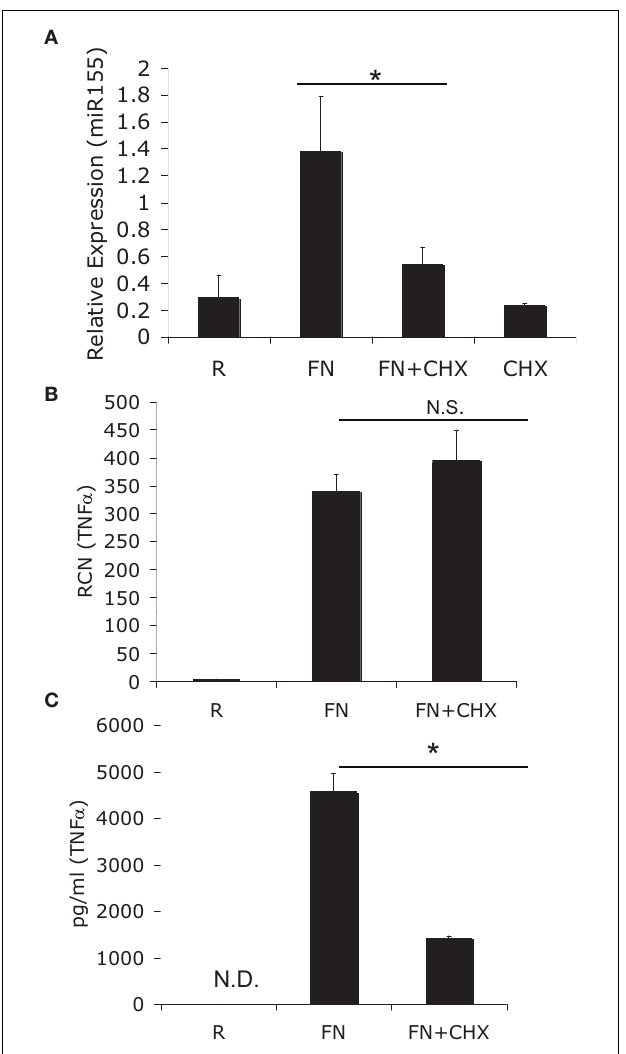
FIGURE 1 | MiR-155 induction requires de novo host-protein synthesis. (A) PBM were infected with F. novicida ( FN ) at an MOI of 50 for 6h in the presence or absence of 2 μ M cycloheximide (CHX), and then RNA was isolated. “R” stands for resting/uninfected cells. Mature miR-155 expression was assayed by qRT-PCR and data expressed as relative expression from triplicate samples. (B) TNF α mRNA was assayed from the same samples as in (A) . (C) SecretedTNF α was measured from the media of the cells in (A) by ELISA. *Designates a p value < 0.05 by Students t -test, while N.S. designates a p value > 0.05.These data are representative of three independent experiments.